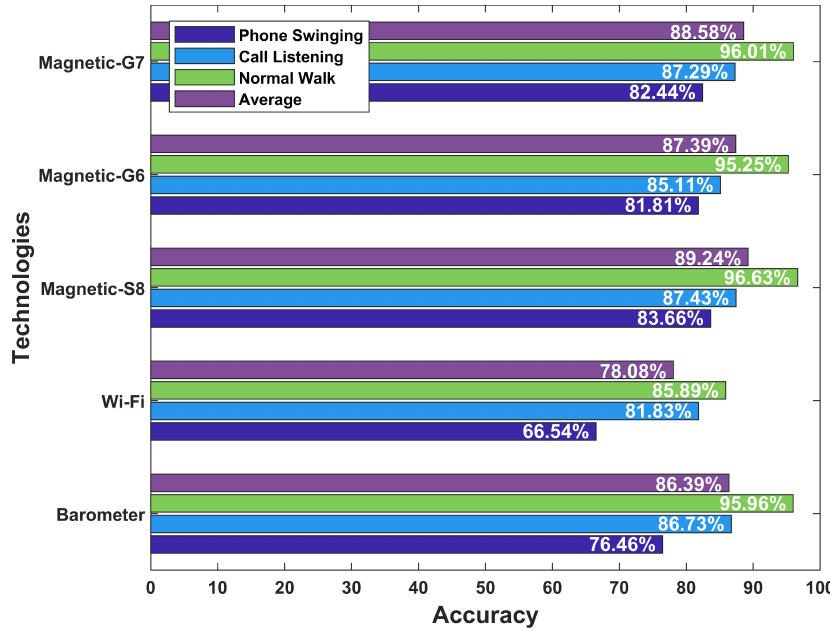
Figure 16. Results for floor